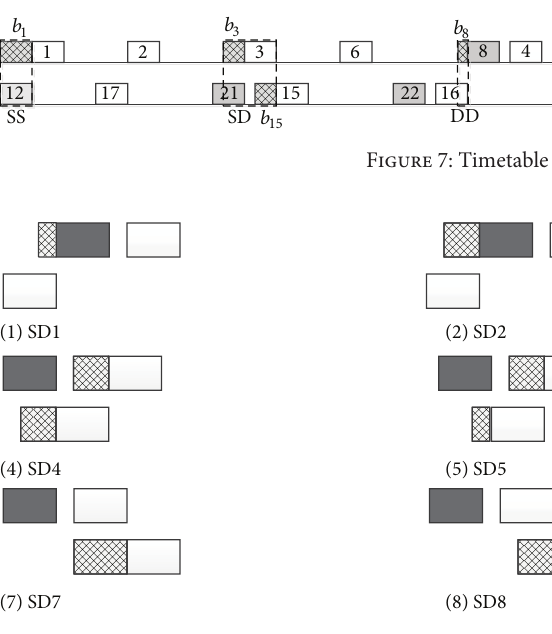
Figure 8: Nine types of SD